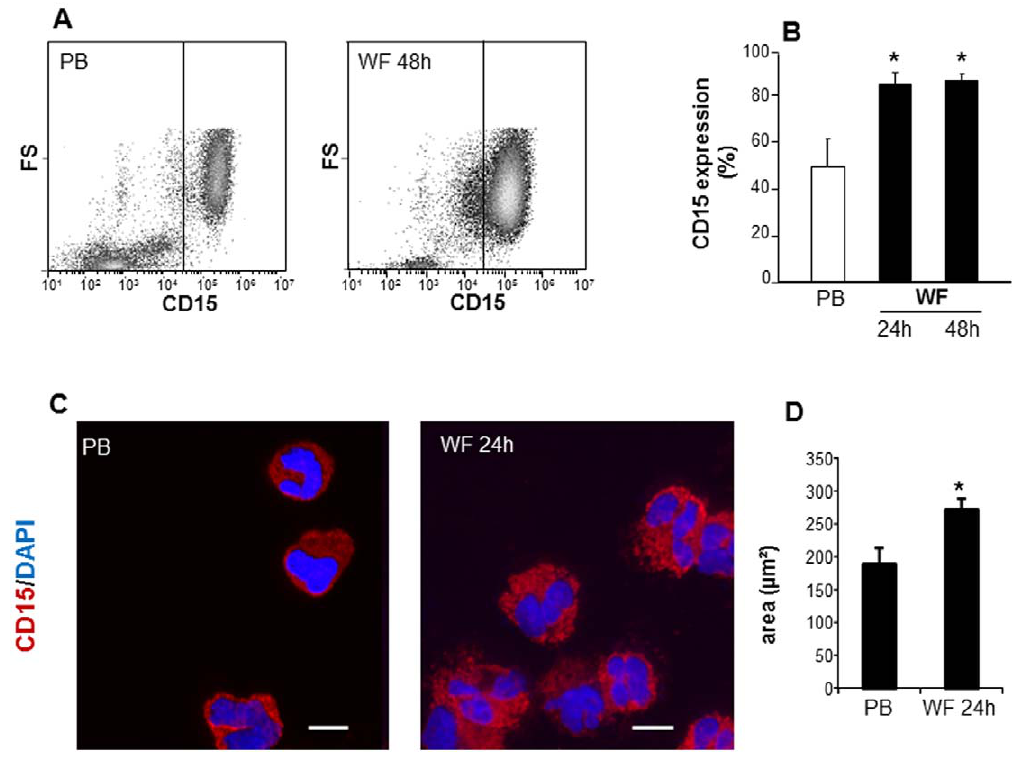
Figure 3. PMN in wound fluid are CD15 positive. PB and WF leukocytes were isolated and stained with FITC-conjugated anti-human CD15 followed by A–B , flow cytometry analysis or C–D , cytospin. A , representative flowcytometry plots showing increased CD15 positive cells in WF at 48 h post wounding as compared to peripheral blood at baseline (PB). B , CD15 expression analysis using flow cytometry. Data presented as mean 6 SD, n=4. * p , 0.05 compared to PB. C , Representative images of cytospun cells derived from WF or PB. Cells were immunostained with CD15 (red) and DAPI (nucleus, blue). Scale bar=10 m m; D , size analysis of cytospun cells derived from WF and PB. Data are mean 6 SD; p , 0.05 compared to